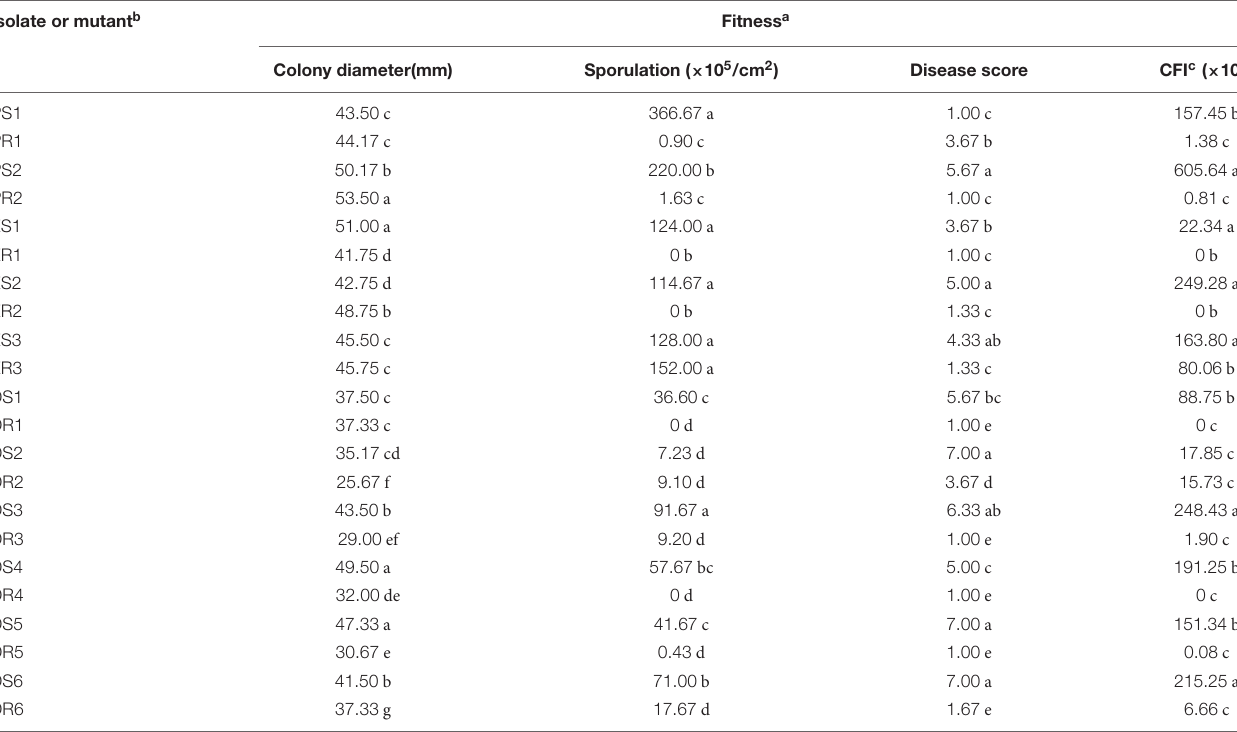
a Values in a column followed by the same letter are not significantly different (P < 0.05). b The first letter refers to the fungicide prochloraz (P), epoxiconazole (E), and difenoconazole (D); the second letter refers to sensitive parental isolates (S) or resistant mutants (R). c CFI: compound fitness index, calculated as in vitro mycelial